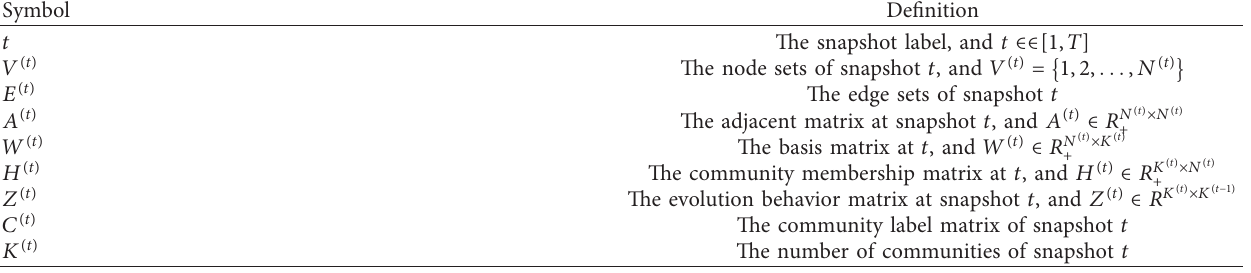
Table 1: Notations.